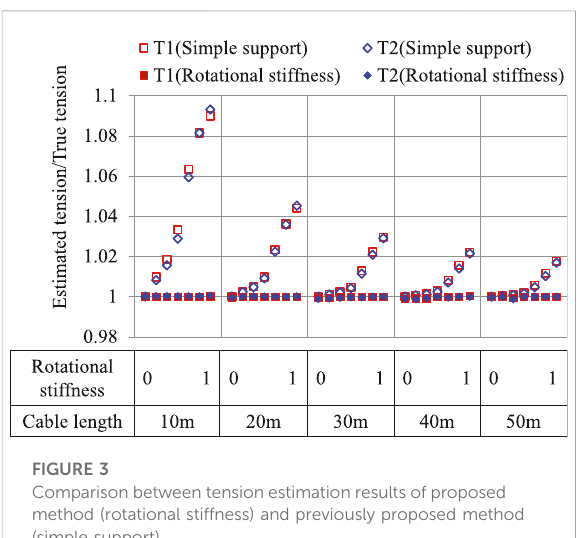
FIGURE 3 Comparison between tension estimation results of proposed method (rotational stiffness) and previously proposed method (simple